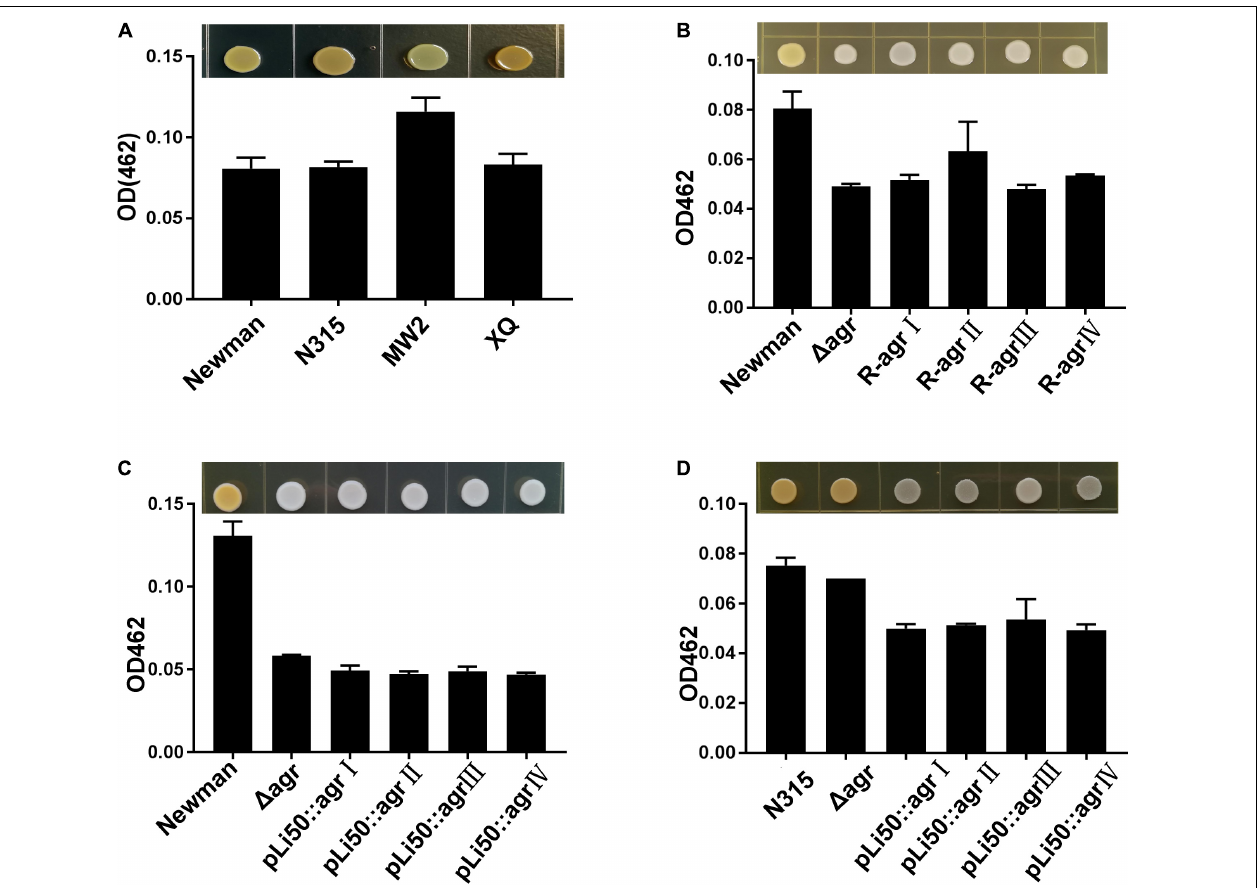
FIGURE 3 | Effects of agr alleles on the pigment formations of S. aureus . The overnight cultures of S. aureus strains with the same CFUs were plated on TSB agar plates and grown for 24 h at 37 ◦ C. (A) Pigment productions of the four wild agr allelic strains: agr I (Newman), agr II (N315), agr III (MW2), and agr IV (XQ). (B) Pigment productions of the wild Newman strain, Newman (cid:49) agrBDC , and agr genomic in situ replacement mutants (R- agr Ito agr IV) of Newman. Pigment productions of the wild type, (cid:49) agrBDC mutants, and pLI50- agr plasmid complement mutants of Newman (C) and N315 (D) . Pigment productions of the relative strains were determined by measuring the optical density